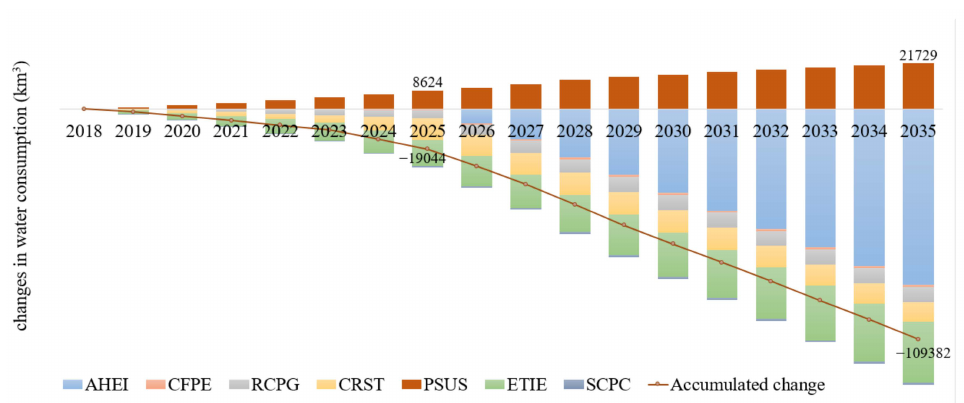
Figure 9. Water consumption variation from REF to GLC